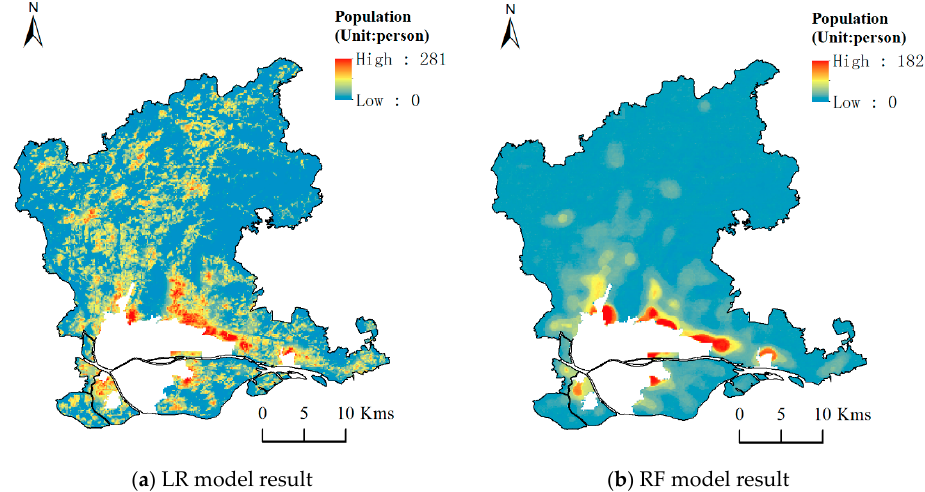
Figure 7. Population distribution maps in sparse area. Table 6. Model accuracy in sparse area.